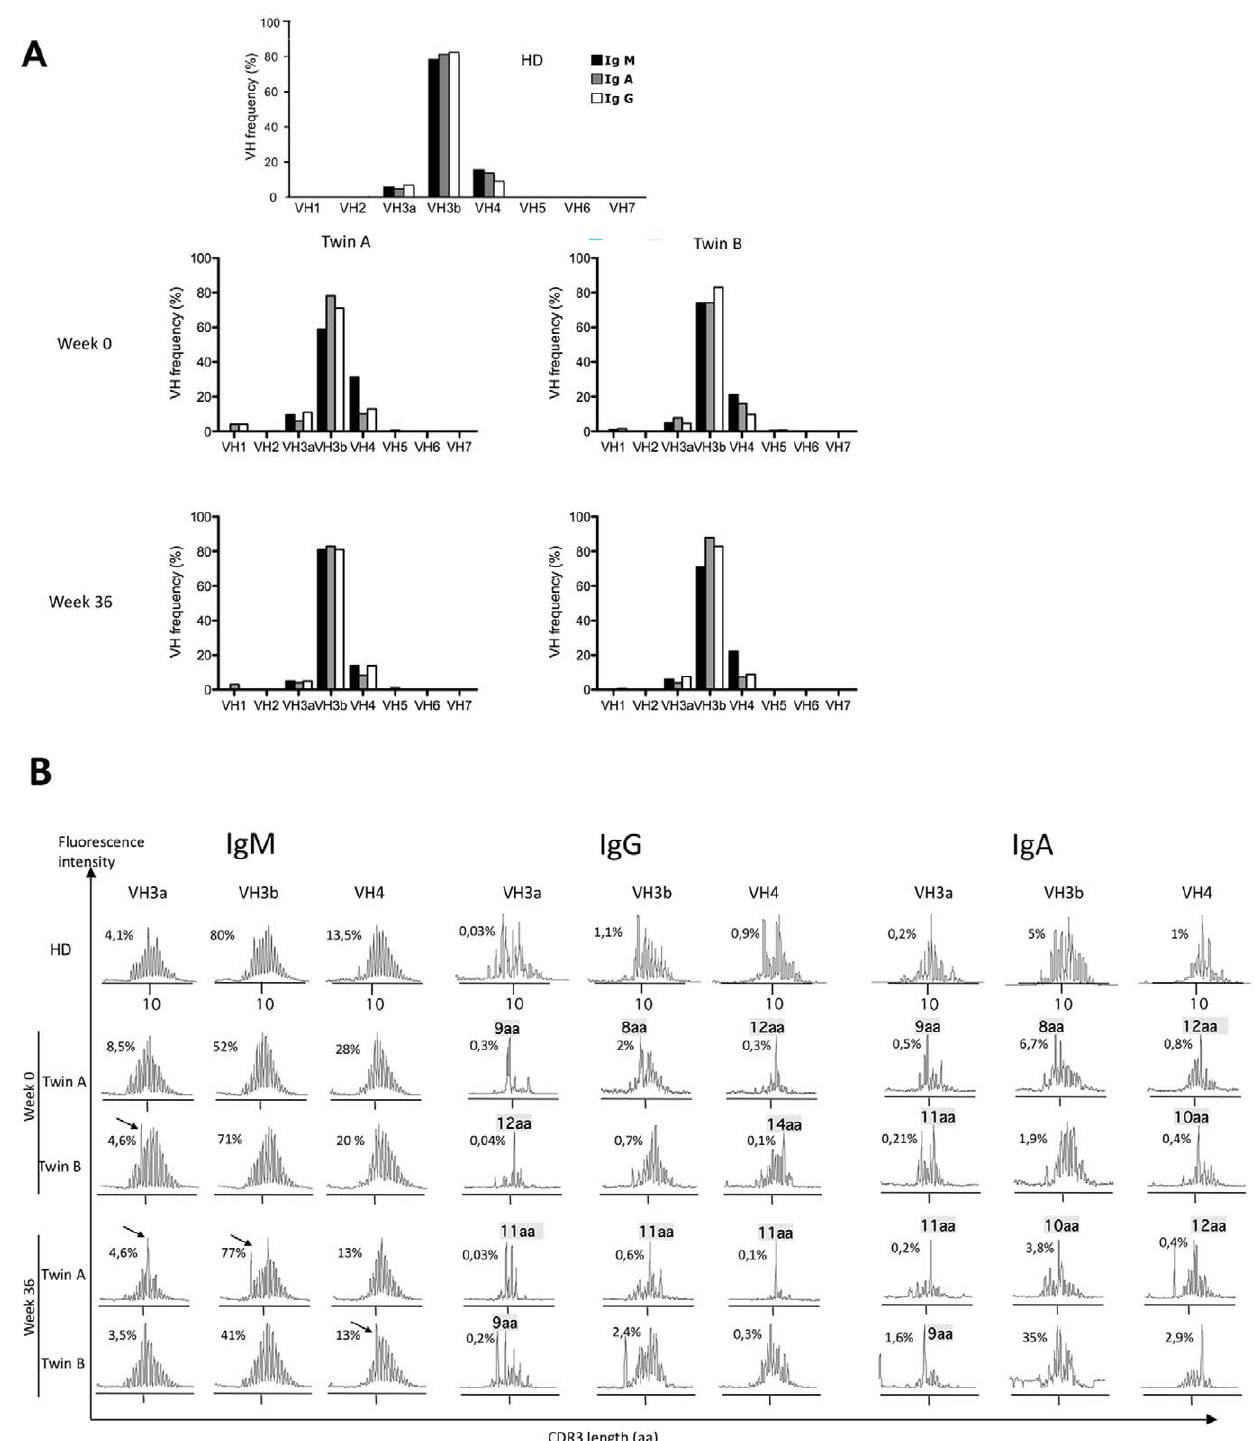
Figure 3. Constant VH usage, but changes in CDR3 length distribution in SPS patients after rituximab treatment. (A) The mean frequency of VH usage for each isotype was determined by quantitative real time PCR analysis on B cells from patients at week 0 and at week 36. As control VH usage by B cells from a healthy donor (HD) is shown. (B) CDR3 length distribution in IgM + , IgG + and IgA + B cell of twin A and B before and after rituximab treatment was analyzed by spectratyping[30]. The x axis of spectratype indicates CDR3 length, whereas the y axis represents the frequency of CDR3 regions. The percentage of VH utilization among all three isotypes is indicated on each profile. Arrows indicate overrepresented CDR3 regions.